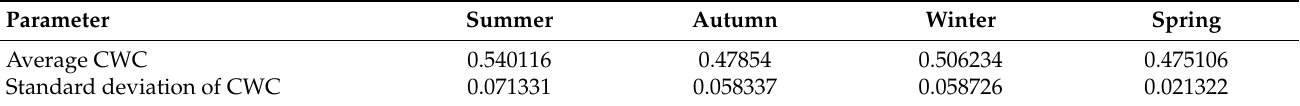
Figure 11. Average value of the median CWC between WT-LUBE-PSO-CWC and BELM for each season in zone 1 and 7. Table 15. Average CWC and standard deviation of CWC per season between both models obtained from both zones.